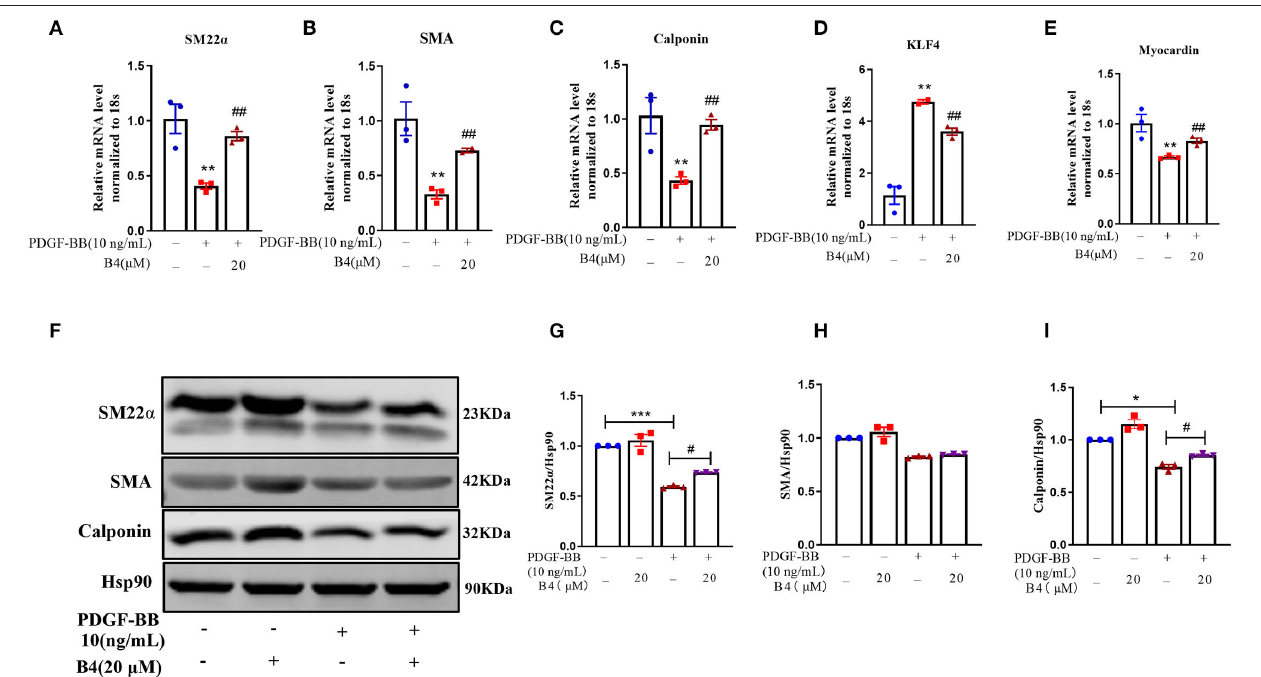
FIGURE 4 | B4 abrogates PDGF-BB-induced MVSMCs dedifferentiation. MVSMCs were pretreated with B4 (20 µ M) for 24h, followed by PDGF-BB (10ng/ml) stimulation for 48h. (A–E) Bar graph showing the relative mRNA level of SM22 α , SMA, Calponin, KLF-4, and Myocardin. (F) Western blot was employed to quantitate the expression levels of contractile protein SM22 α , SMA, Calponin. Hsp90 was used as a loading control. (G–I) Bar graph showing the relative protein level of SM22 α , SMA, and Calponin. Values are mean ± SEM. * P < 0.05; ** P < 0.01; *** P < 0.001 vs. Control, # P < 0.05; ## P < 0.01 vs. PDGF-BB. N = 3 for each